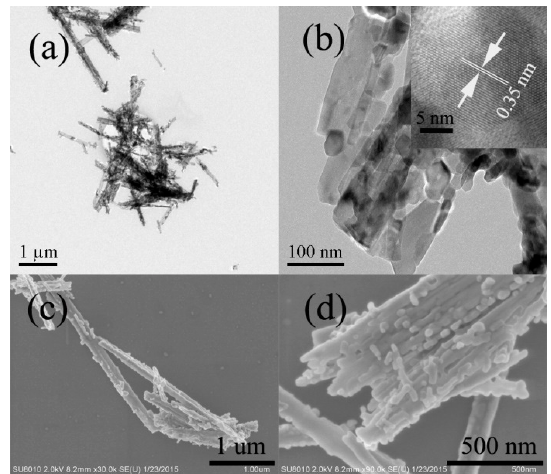
Figure 3. TEM images ( a , b ) and SEM images ( c , d ) of thiourea-modified TiO 2 nanorods (R2), Inset of ( b ) showing the high-resolution TEM image of R2 TiO 2 nanorod.